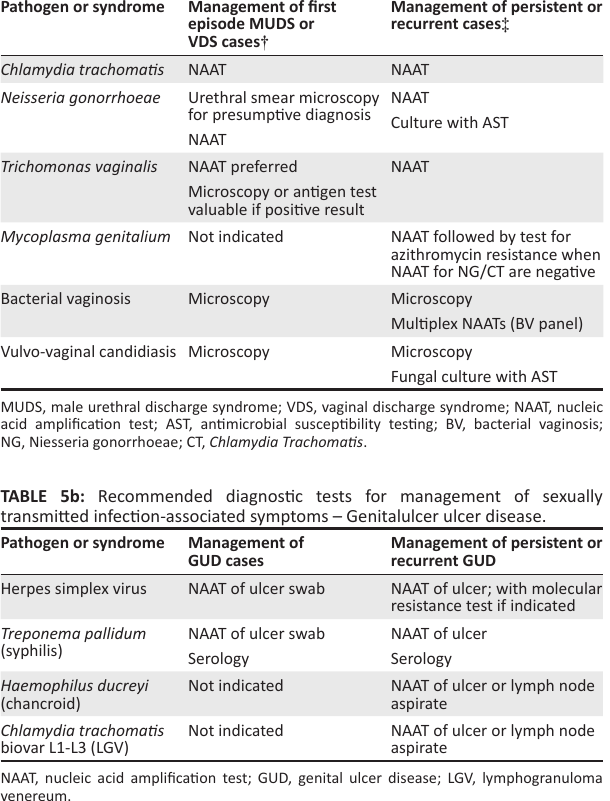
TABLE 5a: Recommended diagnostic tests for management of sexually transmitted infection-associated symptoms – Genital discharge syndromes. Pathogen or syndrome Management of first episode MUDS or